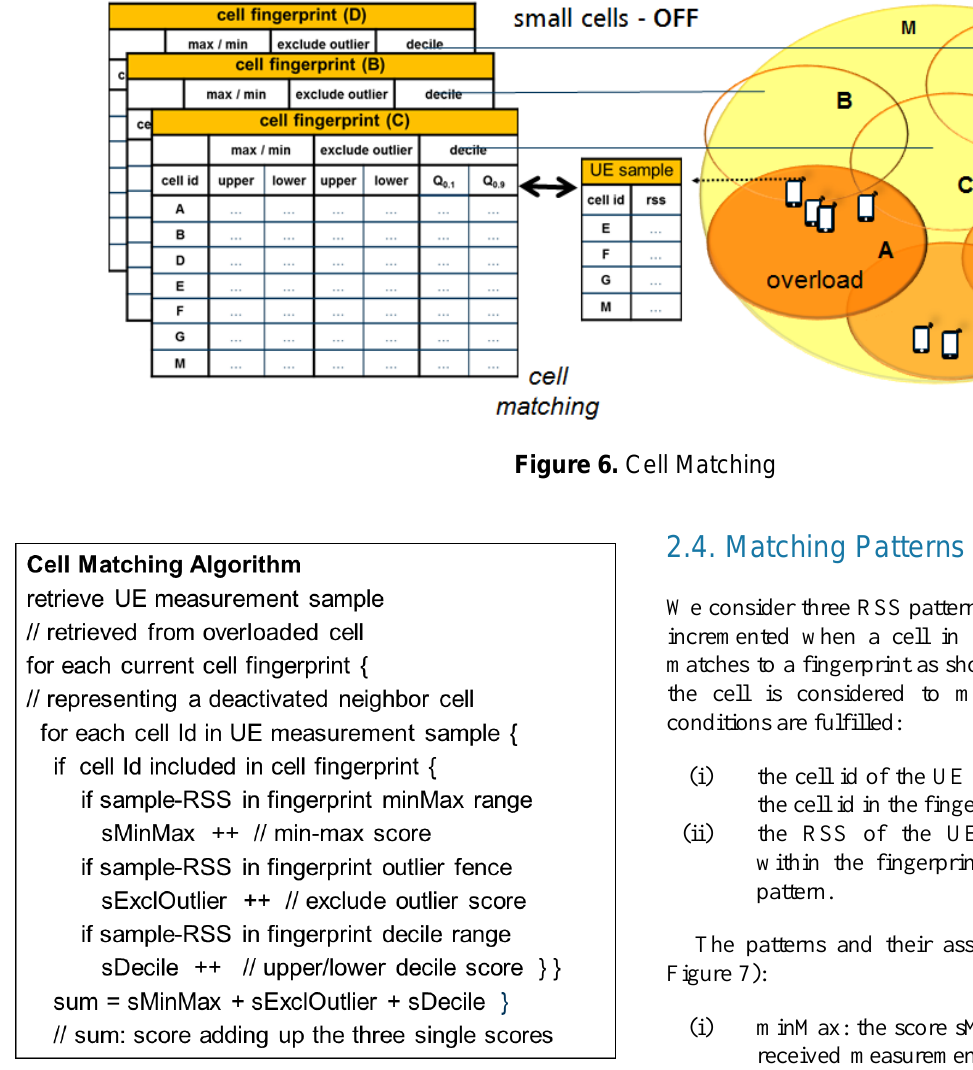
Figure 7. Cell matching algorithm deactivated cells included in the cell fingerprints are ignored. The matching of fingerprints is done based on the characteristics of the ranges of RSS values for the respective cells. Three such options, which we refer to as RSS patterns, are considered for the matching as described in the next section. (iii) Cell selection: For each patterns used, the degree of matching of the sample to the each fingerprint (inactive cell) is scored. Then, the cell(s) with the highest number of scores are determined as the best fitting cell(s) to be activated. The number of cells to be concurrently activated is controlled by input policy as set by the operator. Meanwhile, the activation of the selected cell(s) is triggered via the X2 interface by the overloaded cell that undertakes the